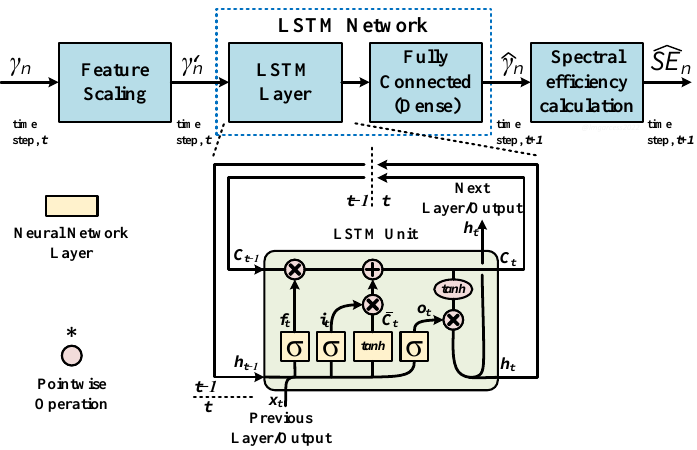
Figure 5. LSTM network for predicted